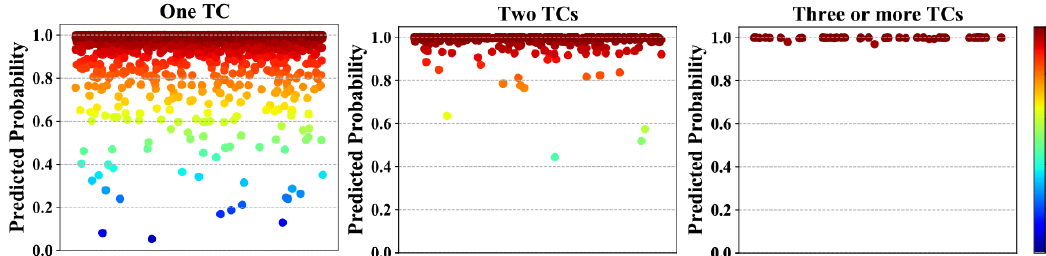
Figure 20. Prediction probability for NWPO images involving multiple TCs.